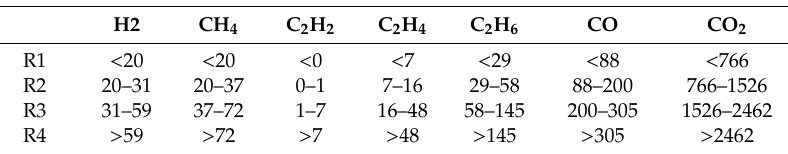
Table 7. Rate of gas increase